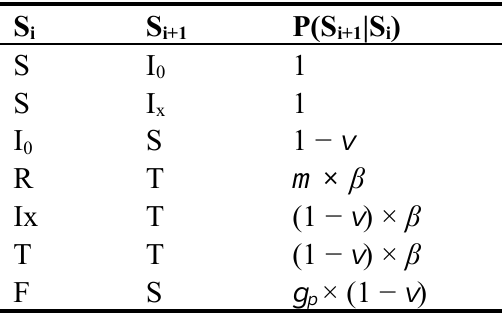
Table 2. Scheduling Probabilities of